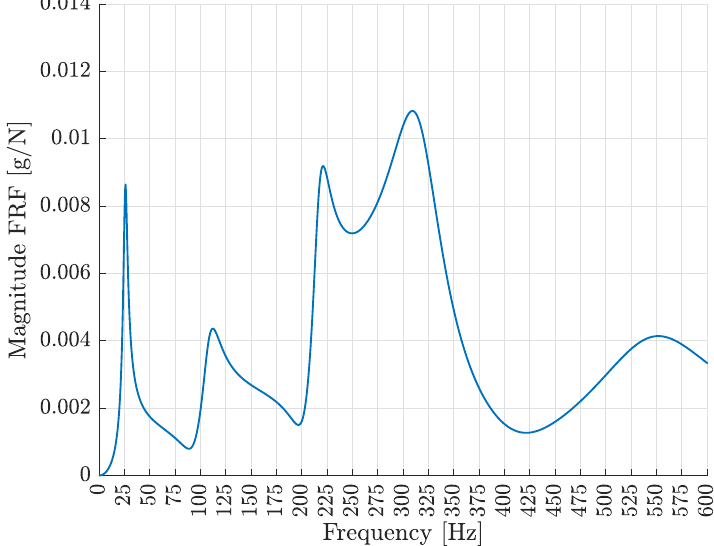
Figure 19. FRF between the acceleration ¨ x b and the cutting force in the X-direction, assuming the cutting head in center-center (CC)